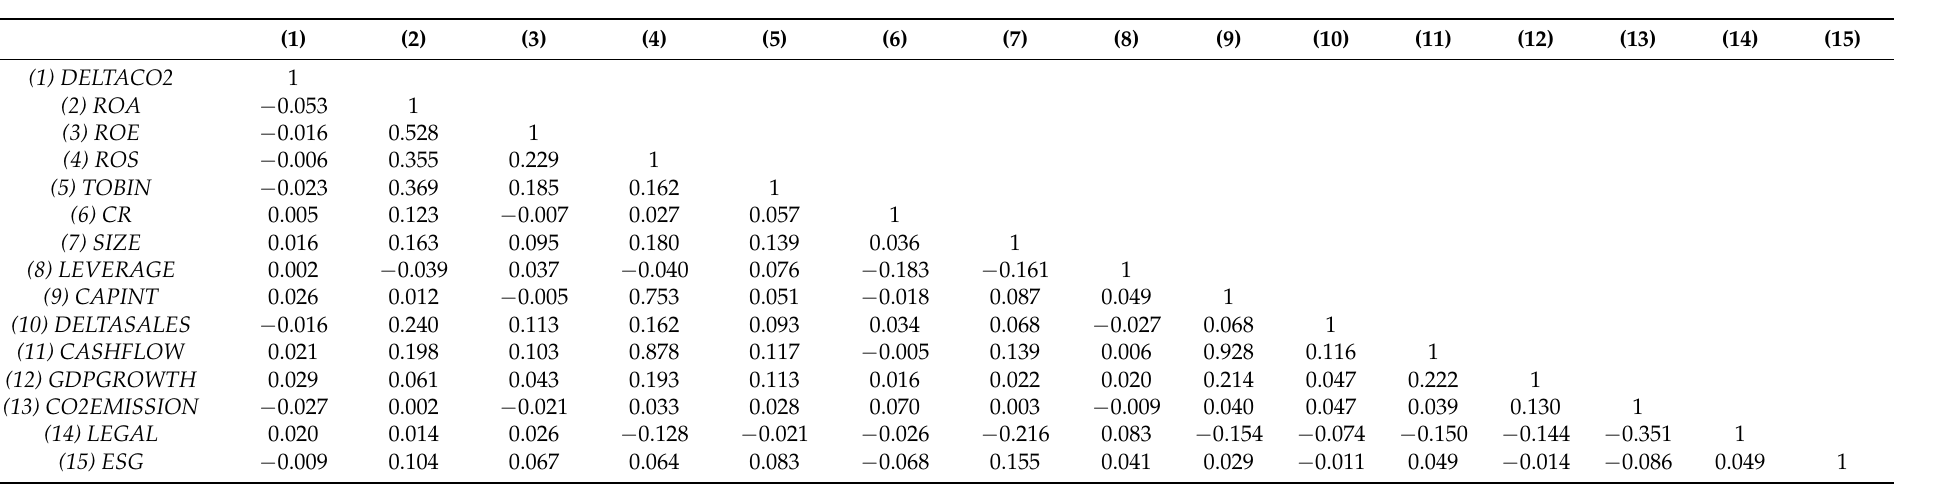
Table 2. Pearson correlation